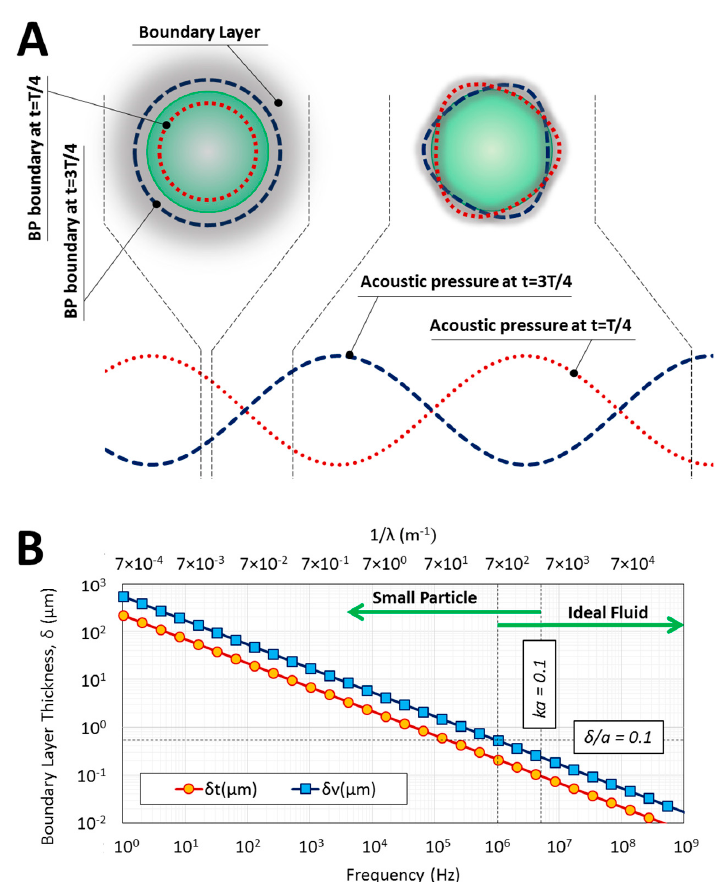
Figure 1. Harmonic behavior of a typical bio-particle (BP) in standing acoustic field with different applied frequencies. ( A ) Sketches of the BP under low (left) and high (right) frequency actuations; ( B ) The validity range of small particle and ideal fluid assumptions for a typical BP. In low frequencies, thermal and viscous boundary layer thicknesses ( δ t and δ v , respectively) are comparable to the BP size, therefore the fluid cannot be considered with ideal theory (see Equations (S1) and(S2)). In addition, for wavelengths much larger than particle size (i.e., ka (cid:28) 1, in which k is the wave number), the BP boundary experiences either negative or positive pressure. At higher frequencies, boundary layers are thinner. On the other hand, a complex deformation and harmonic behavior are experienced by the BP given the fact that different points of the BP boundary experience different pressure values. Therefore, the BP size cannot be neglected for higher frequencies. The values are calculated based on the parameters presented in Section 2.3.